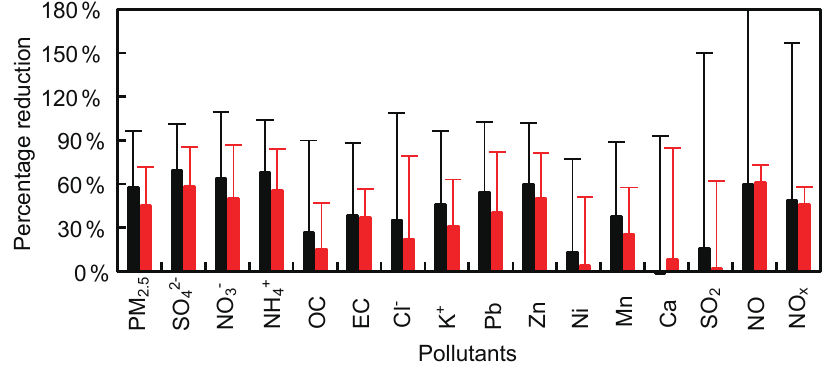
Figure 6. The percentage reductions of pollutant concentrations under similar meteorological conditions. The black bars represent the percentage reductions calculated by comparing the decreased average concentrations during APEC to the average concentrations before APEC. The red bars represent the percentage reductions calculated by comparing the decreased average concentrations during APEC to the average concentrations before APEC based only on the days with stable meteorological conditions. The whiskers represent the SDs of the percentage